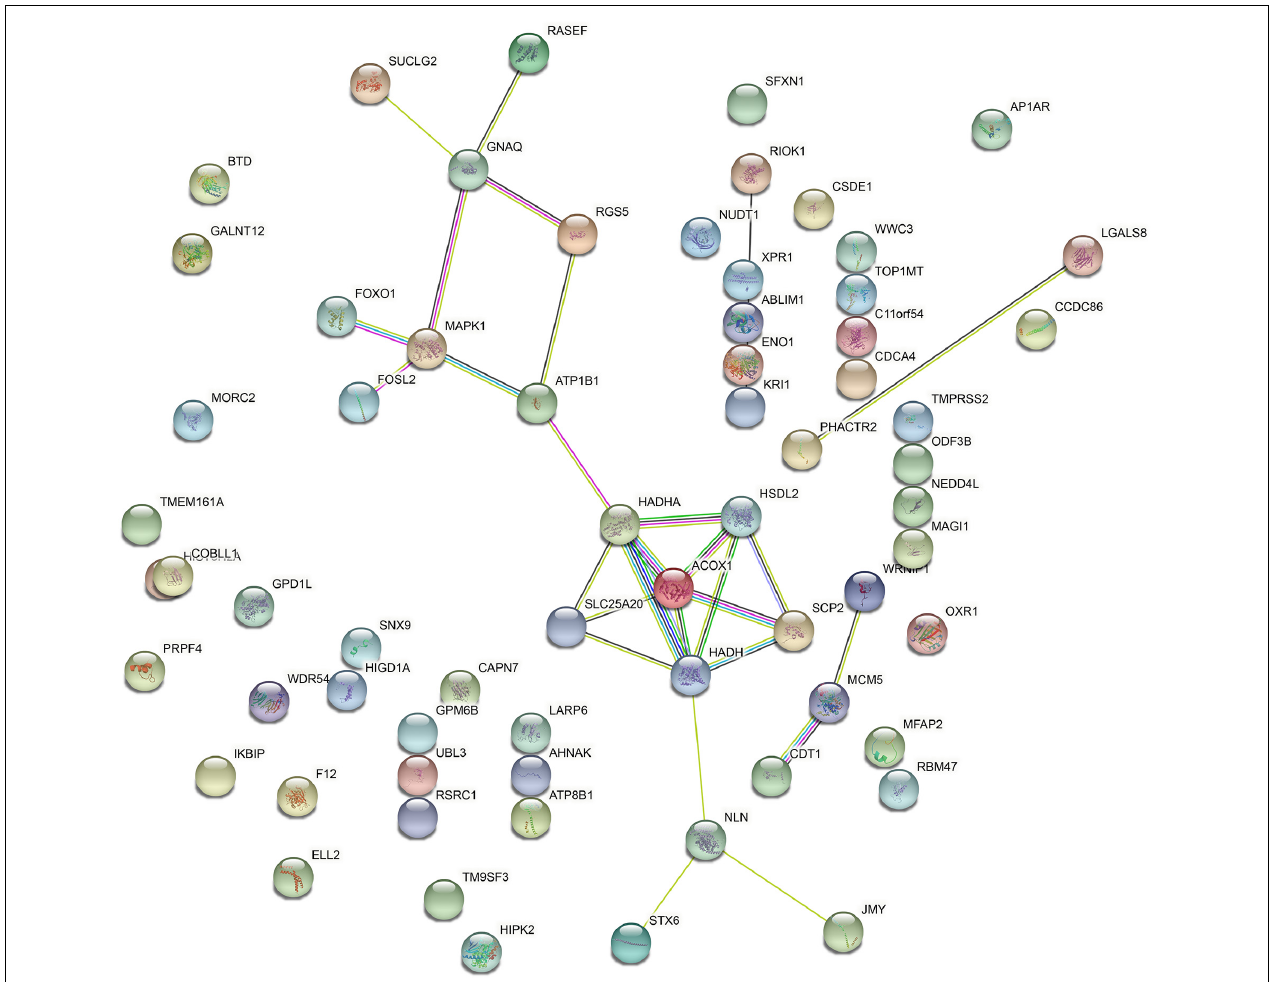
FIGURE 6 | The protein–protein interaction (PPI) network of differentially expressed genes (DEGs) was